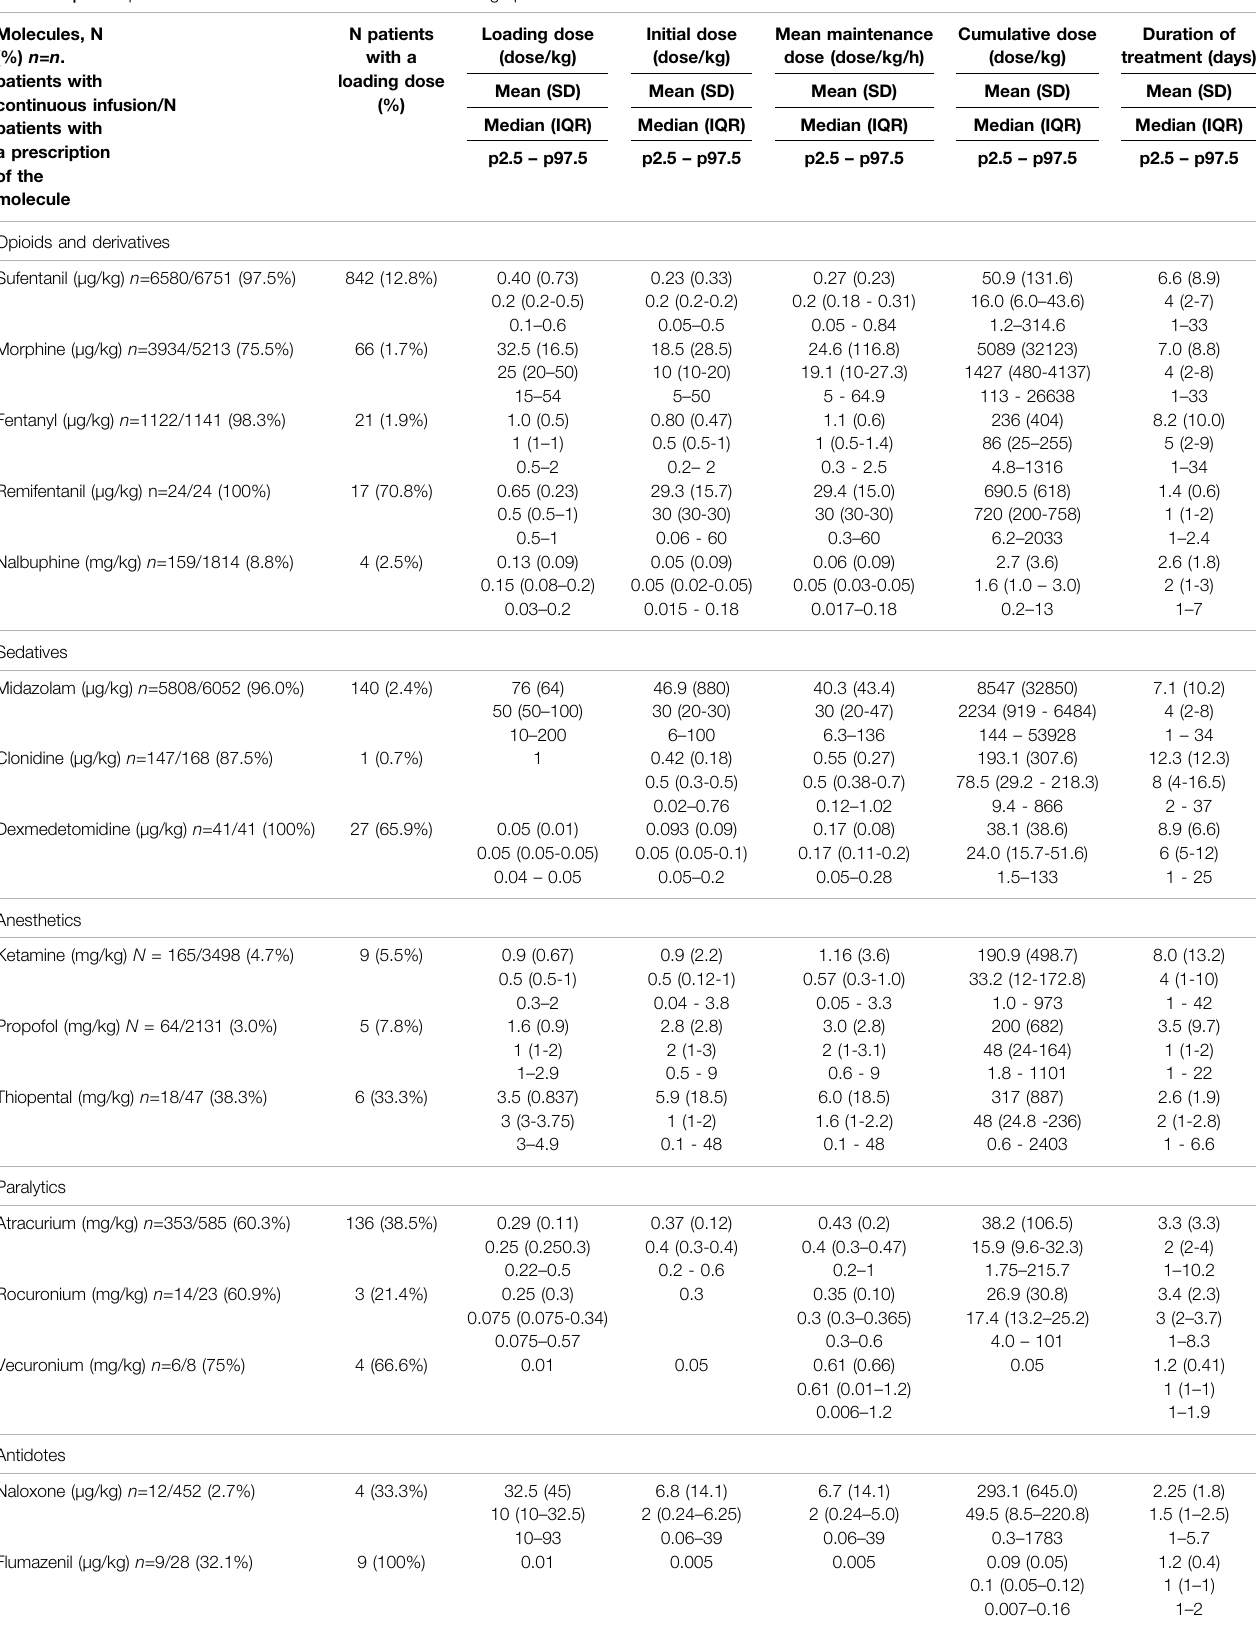
TABLE 3 | Description of doses and duration of treatment for drugs prescribed as continuous infusion Molecules, N (%) n = n